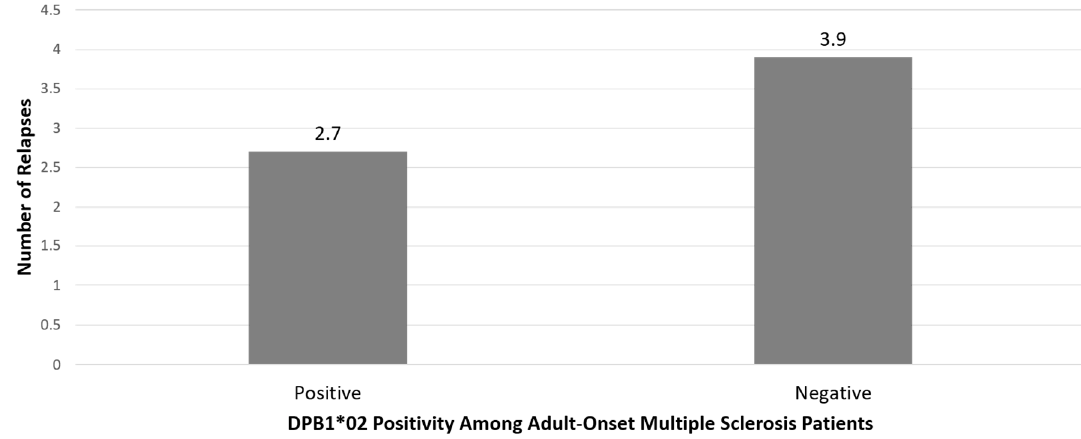
Figure 1. Number of relapses in adult-onset Multiple Sclerosis Patients with regards to HLA- DPB1*02 genotype. Positive patients had significantly fewer relapses than negative ( p =